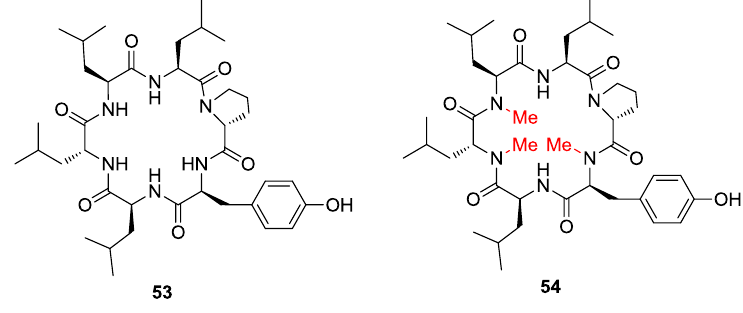
Figure 11. Structures of cyclohexapeptides 53 and 54 .